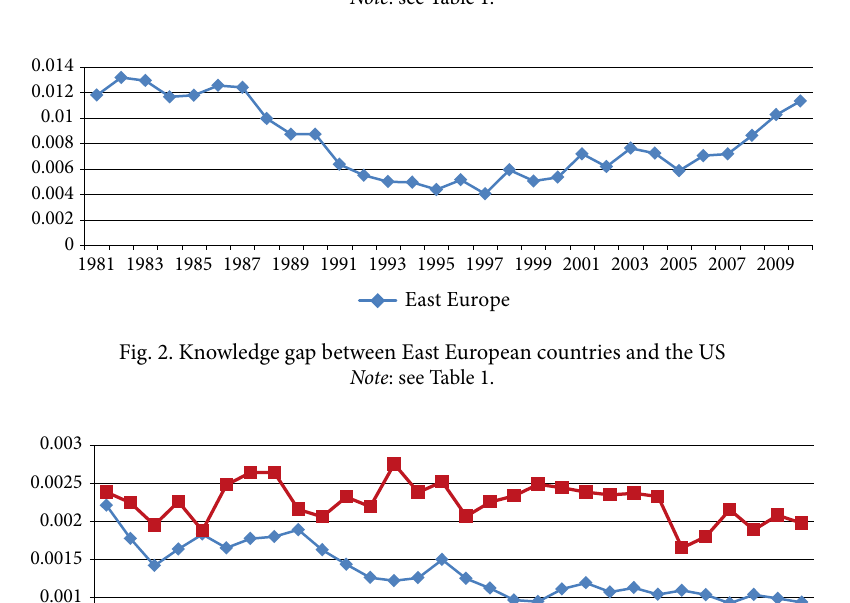
Fig. 1. Knowledge gap between Asian countries and the US Note : see Table 1.